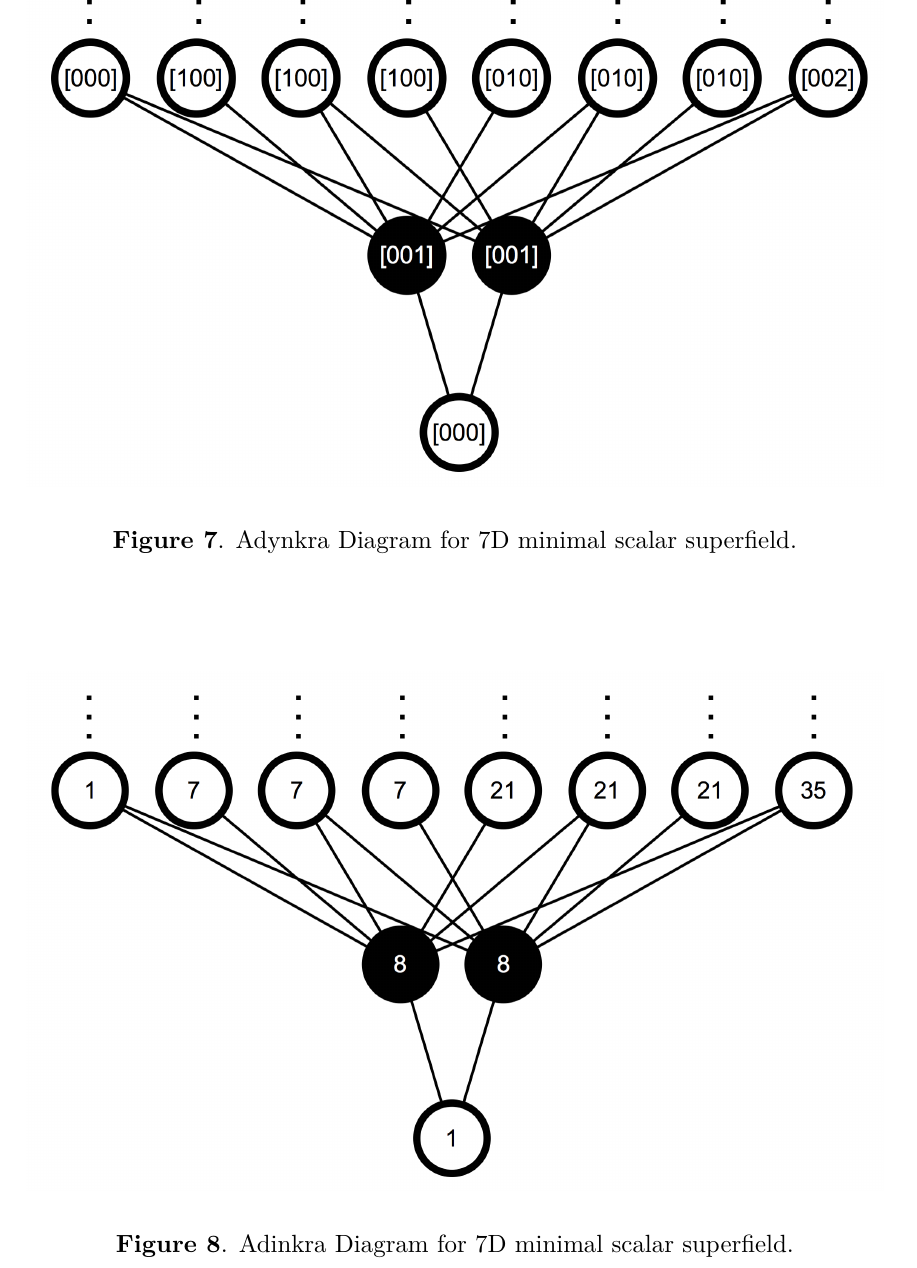
Figure 8 . Adinkra Diagram for 7D minimal scalar